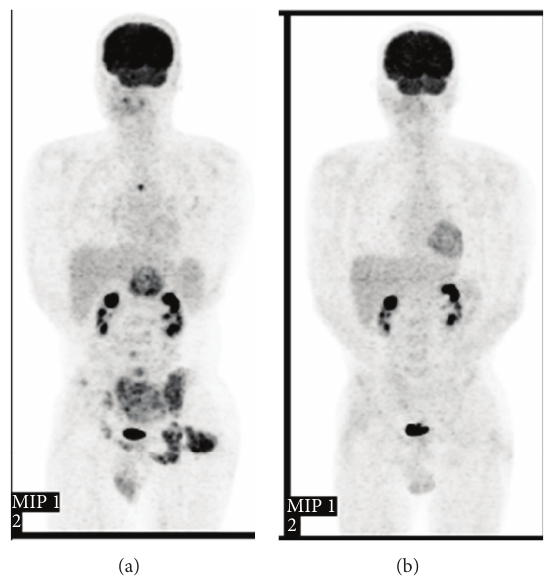
Figure 4: (a) Preoperative positron emission tomography, showing areas of increased uptake in the pancreas, left buttock, pelvis, and the thoracic, lumbar, and sacral vertebrae. (b) The areas of increased uptake disappeared after eight cycles of chemotherapy.